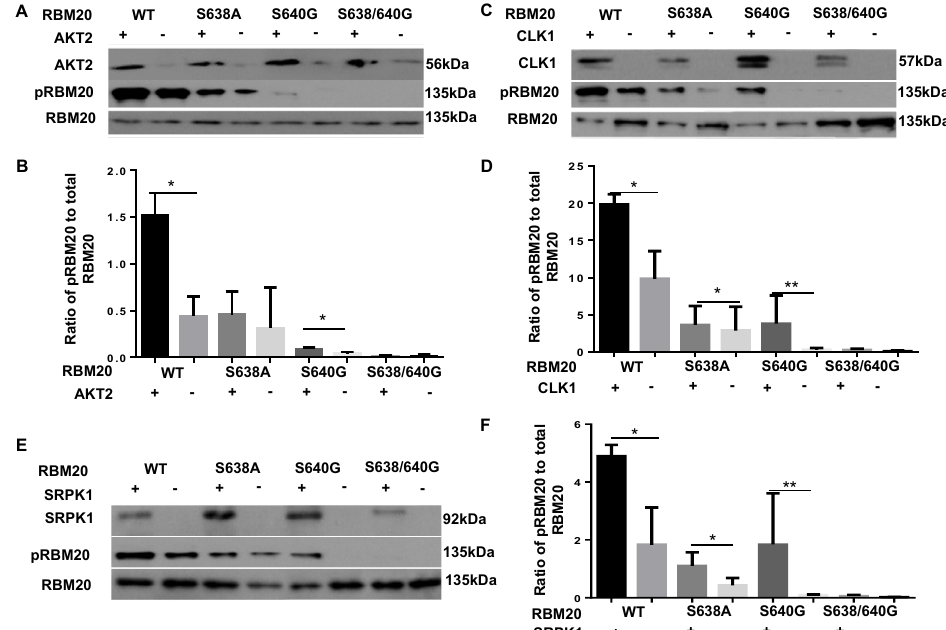
Figure 1. SR protein kinases phosphorylate serine residues in the RBM20 RSRSP stretch in HeLa cells ( A , C , E ). HeLa cells were co-transfected with plasmids carrying the SR protein kinases AKT2 ( A ), CLK1 ( C ), or SRPK1 ( E ) and WT or mutant RBM20. Cell lysates were subject to immunoblotting with antibodies against pRBM20, RBM20, AKT2, CLK1, and SRPK1. Blots shown are representative of three independent experiments. Transfection of SR protein kinase plasmids increased the expression of the respective kinases significantly ( B , D , F ). Quantification of RBM20 phosphorylation in HeLa cells co-transfected with individual kinases or empty plasmid (control). Data are shown as mean ± SD ( n = 3); * p < 0.05, ** p < 0.01. WT, wild type.